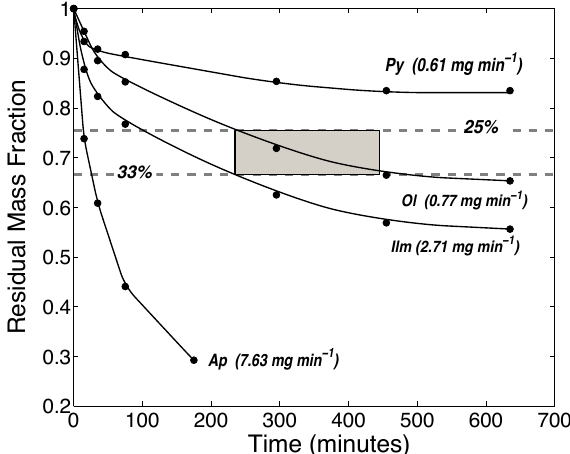
Figure 9. Experimentally measured mass loss rates for four com- mon kimberlitic mineral phases (after Afanas’ev et al., 2008). Residual mass fractions of minerals pyrope (Py), picroilmenites (Ilm), olivine (Ol), and apatite (Ap) being abraded experimentally are plotted against duration (e.g. time). The slopes to the curves de- fine the instantaneous mass loss rates; also shown are the average mass loss rates for each phase (mgmin − 1 ) . The grey box denotes the estimated mass loss for Igwisi Hills olivines based on their shape (e.g. smoothness, roundness) relative to the calibrated photographs of Afanas’ev et al.